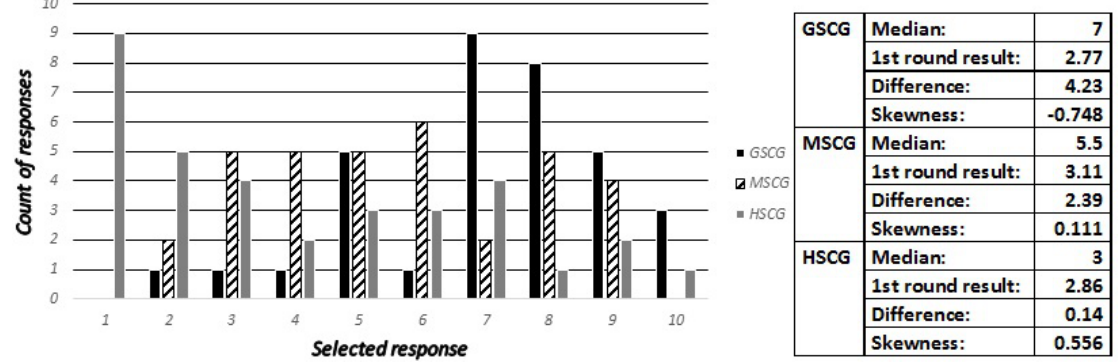
Figure 10. Expert predictions for question